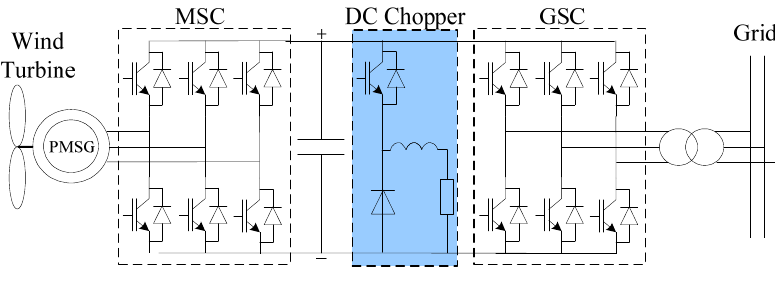
Figure 2. The structure of PMSG WT system.